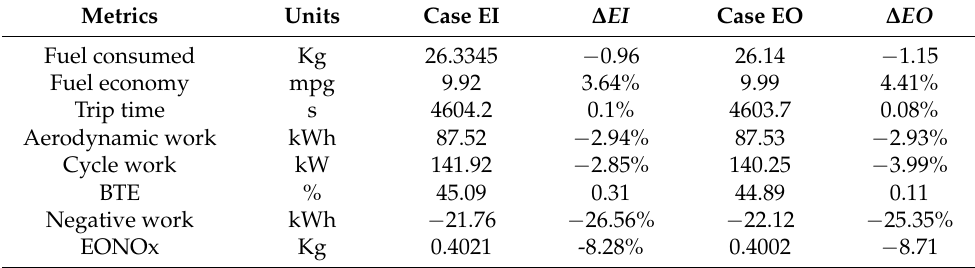
Table 5. Comparison of key metrics for the vehicle speed and coast management problem with engine idle and engine-off condition. The ∆ % is the comparison with the baseline